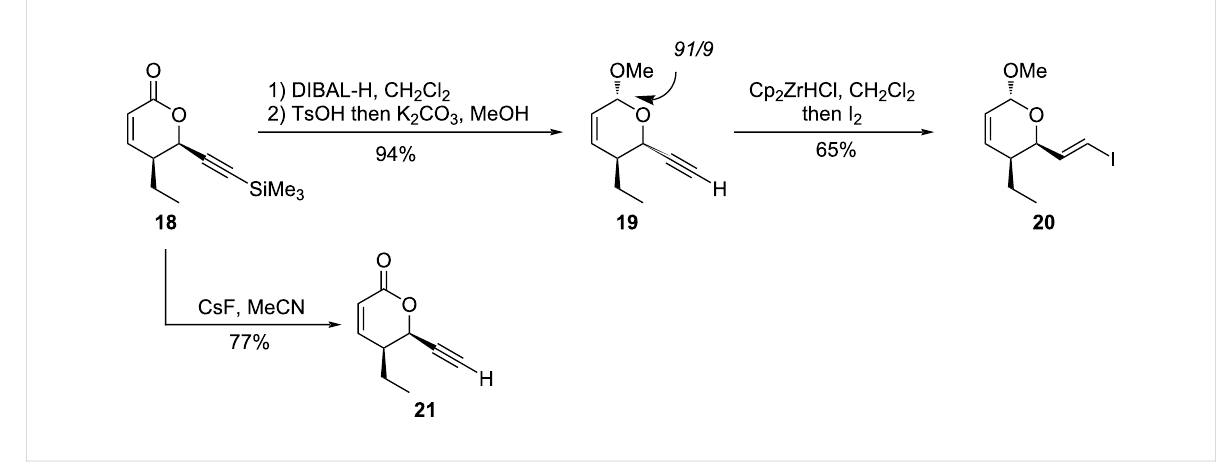
Scheme 6: Synthesis and derivatization of the lactone fragment.